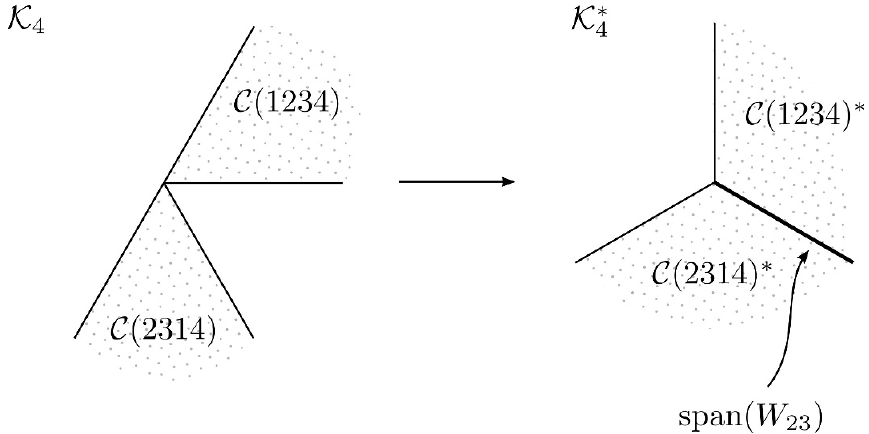
Figure 2 . The cones C (1234) and C (2314) do not intersect in kinematic space, K 4 . However, the dual cones C (1234) (cid:3) and C (2314) (cid:3) do intersect, and their intersection can be regarded as encoding the amplitudes m (1234 j